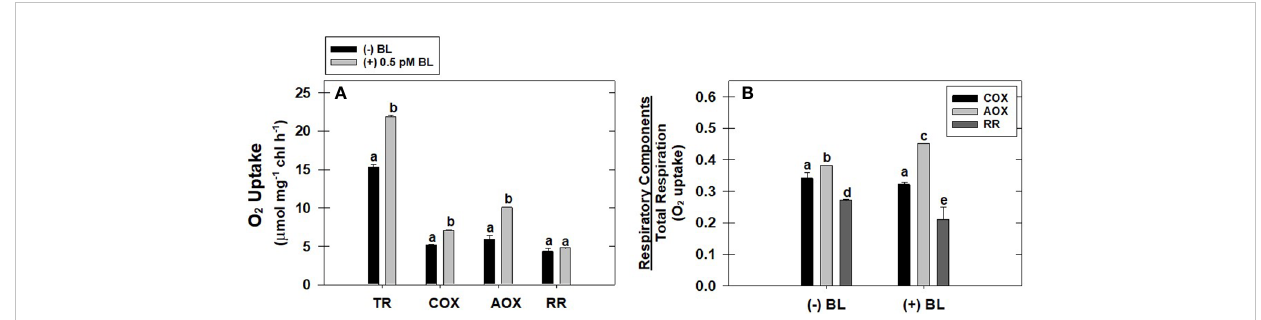
FIGURE 2 Effect of BL on the different components of TR: capacity of COX pathway, AOX pathway, and RR (A) . The ratio of O 2 uptake by each of these components to total respiration in MCP of A. thaliana (B) . The MCP in the reaction medium was pre-incubated for 10 min in the presence of 0.5 pM BL at a light intensity of 1000 m mol m -2 s -1 at 25°C. After treatment, MCP was shifted to an oxygraph cuvette to monitor various components of respiration. Further, the section “ materials and methods ” mentions more detailed information on the procedure. A statistically signi fi cant difference is represented by different lowercase alphabetical letters (P ≤ 0.05) and values represent the average (± SE) of three